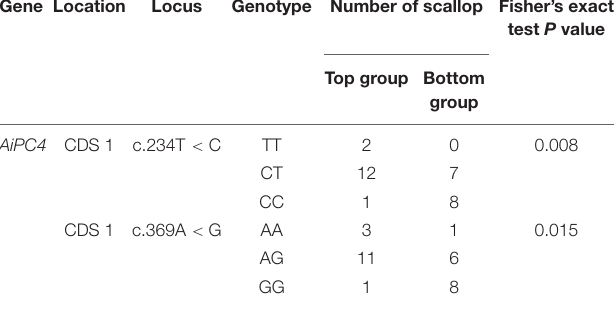
TABLE 3 | Comparison of genotype frequencies of SNPs in AiPC4 CDS 1 between the top ( N = 15) and the bottom ( N = 15) scallop groups classified by the ABT values of thermal tolerance.